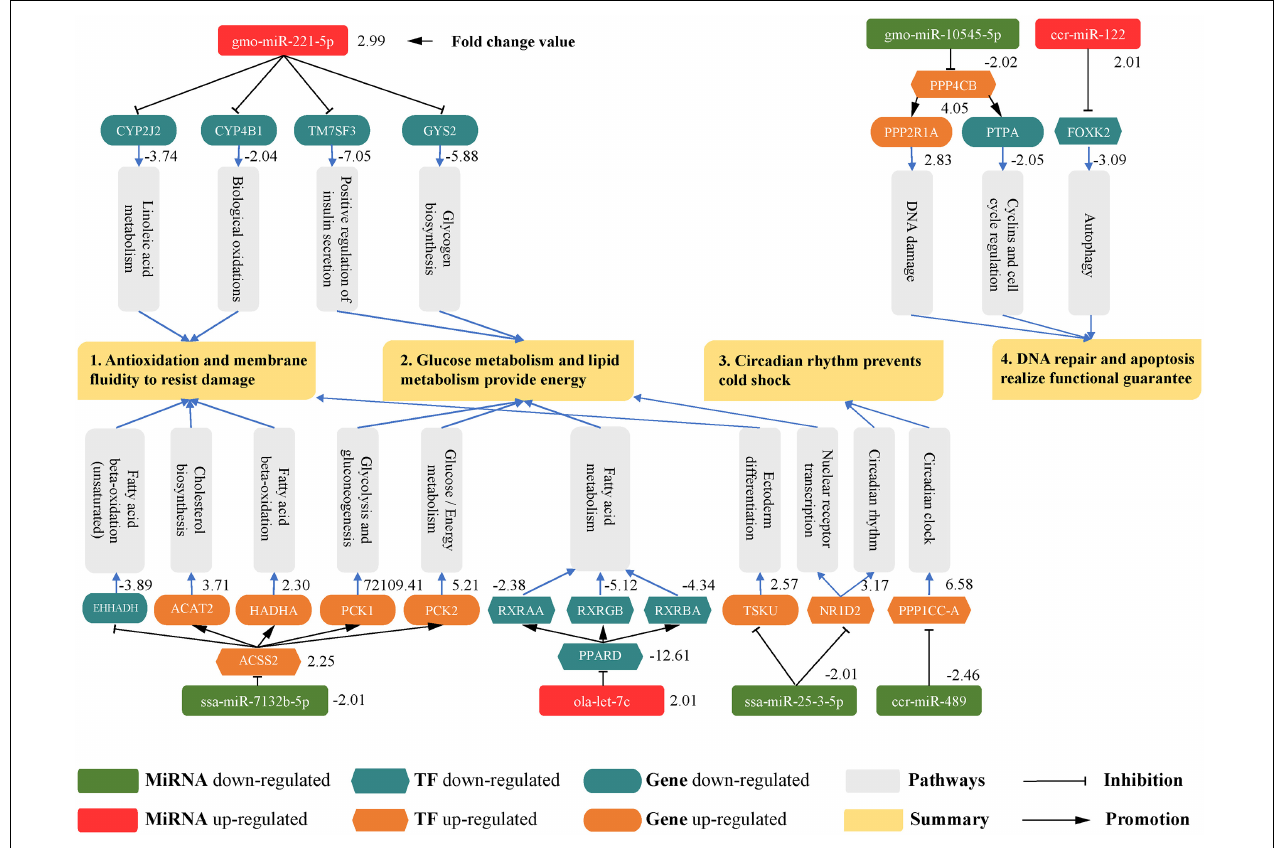
FIGURE 11 | Several important pathways and biological reactions associated with the miRNA-TF-mRNA regulatory network involved in the response to cold stress in pearl gentian grouper.